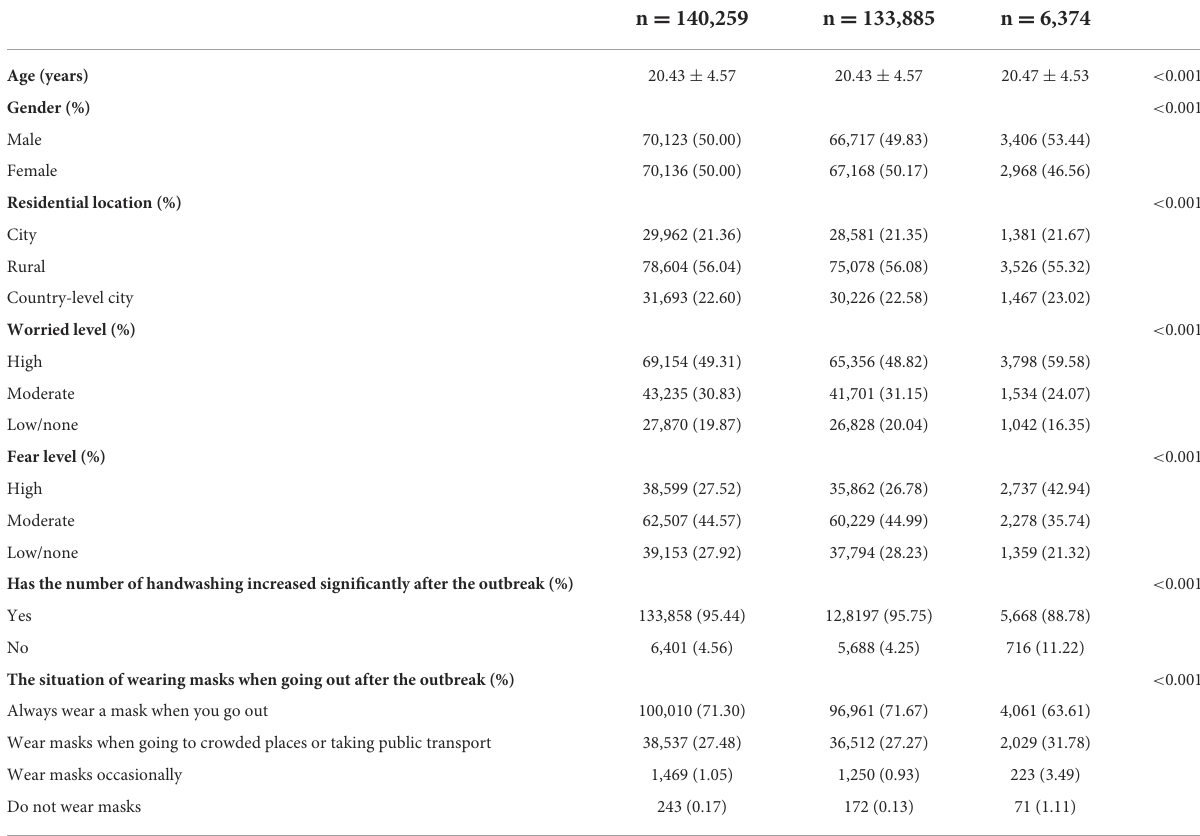
TABLE 1 Characteristics of the study participants by depression